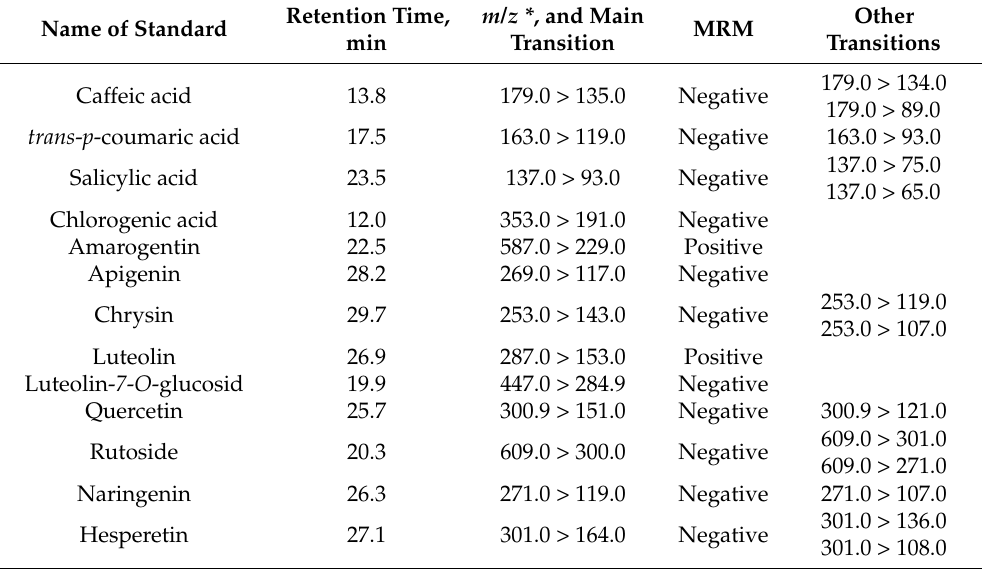
Table 7. LC-MS standards identification parameters.